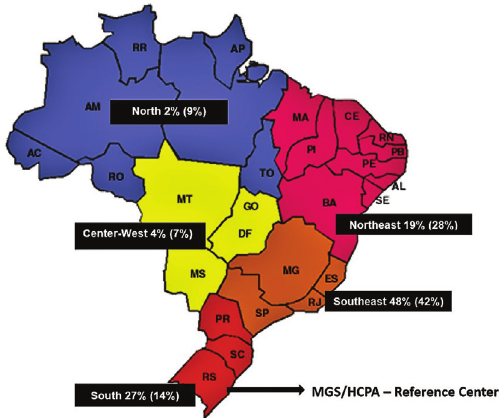
Figure 2 - Percentage of LSDs diagnoses from different Brazilian regions (percentage of the Brazilian population living the region indicated be- tween parenthesis).